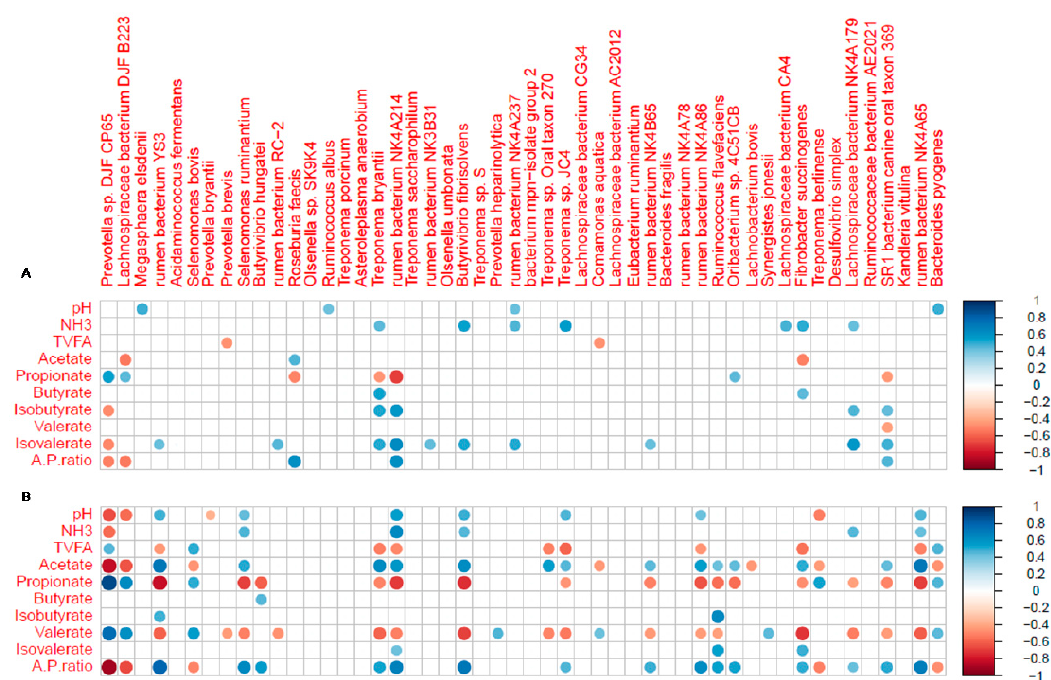
Figure 7. Spearman’s rank correlations between rumen fermentation parameters and relative taxa abundance in ( A ) two-month-old and ( B ) six-month-old calves. Only bacterial species with a relative abundance > 0.01% in at least one sample were included in the correlation analysis. Correlations with a threshold of statistical significance at p < 0.05 were visualized. The degree of correlation is indicated by the size of the circle. The blue color represents a positive correlation and the red color represents a negative correlation.